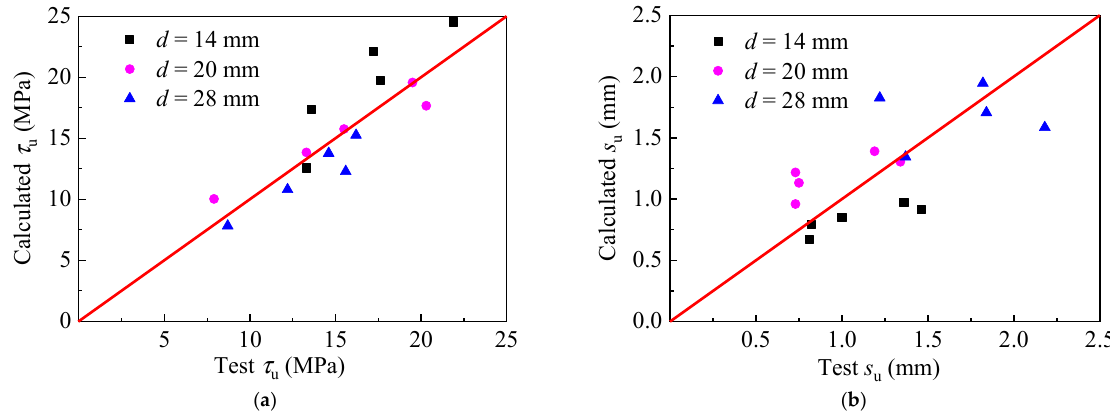
Figure 8. Comparison of test and calculated results: ( a ) bond strength τ u ; ( b ) slip s u . The relationship of bond stresses and slips at key points of complete bond stress-slip curves with the bond strength τ u and peak slip s u are presented in Figure 9. Based on the regression, τ s , τ cr , τ r were 0.68, 0.87, 0.29 times of τ u , while s s , s cr , s r were 0.24, 0.43, 9.51 times of s u , respectively. On account of the calculation method of these bond strengths and slips on the bond stress-slip curves, complete curves can be predicted by the prediction model in the absence of test data.